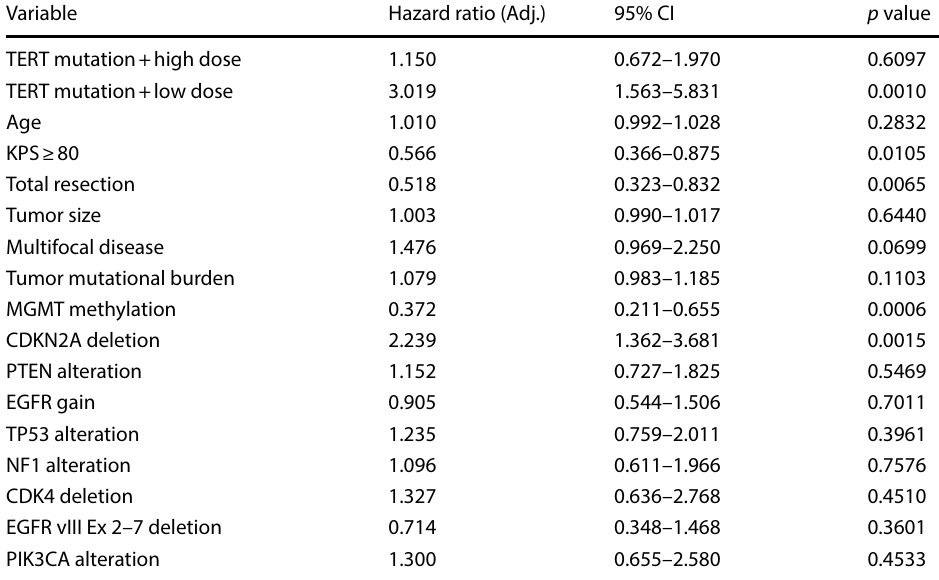
Table 5 Multivariable analysis of impact of TERT mutation status and radiation dose on OS in full patient cohort